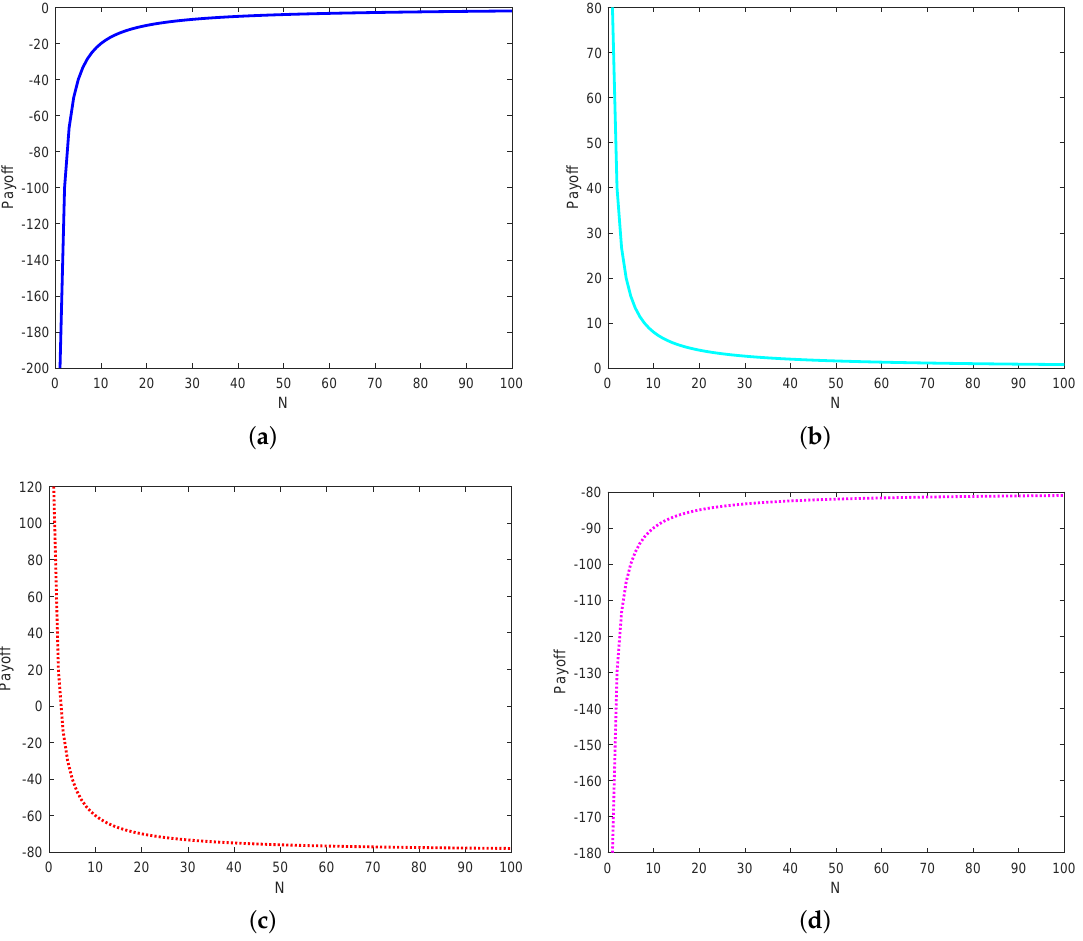
Figure 10. ( a ) Payoffs of a server in the strategy set ( Real service-on, Access ); ( b ) Payoffs of a server in the strategy set ( Fake service-on, Access ); ( c ) Payoffs of an attacker in the strategy set ( Real service-on, Access ) ; ( d ) Payoffs of an attacker in the strategy set ( Fake service-on, Access )